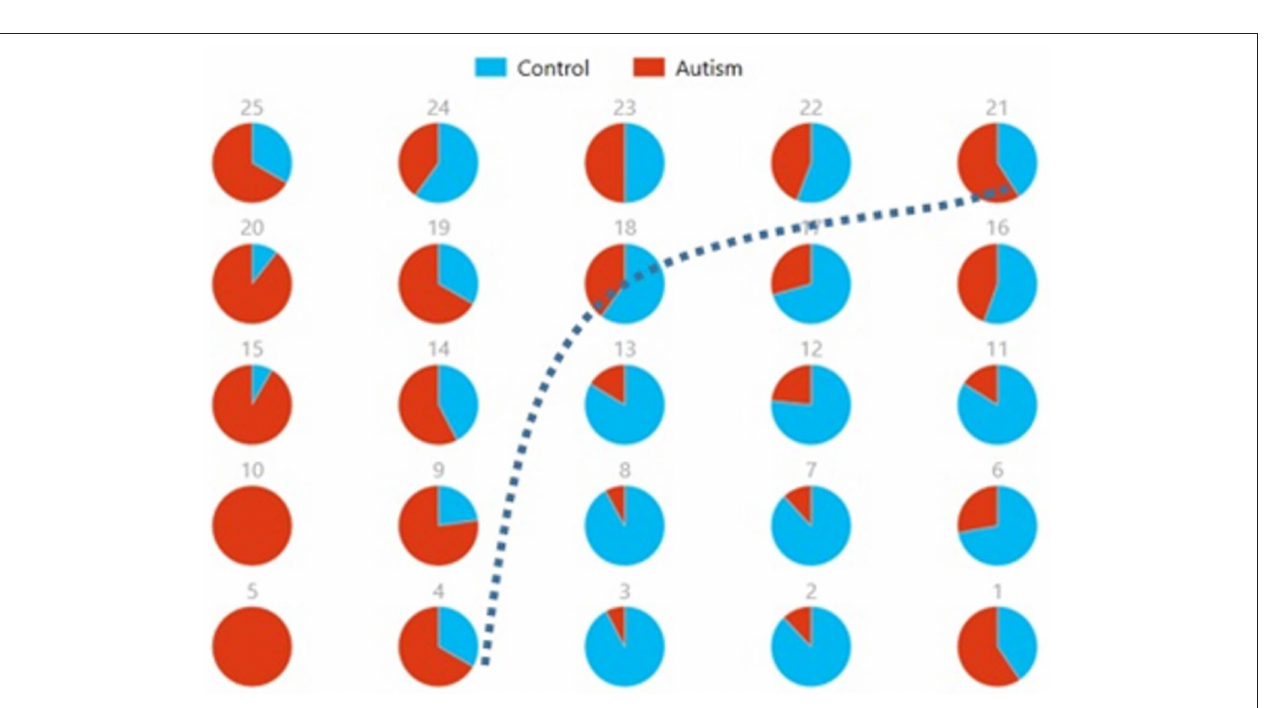
FIGURE 13 | Pie chart visualizations based on a 5 × 5 SOM for A x and C x a showing Autism and Control groups by neuron where the number on each chart corresponds to a neuron in the SOM. The dotted line represents approximate separation between the two